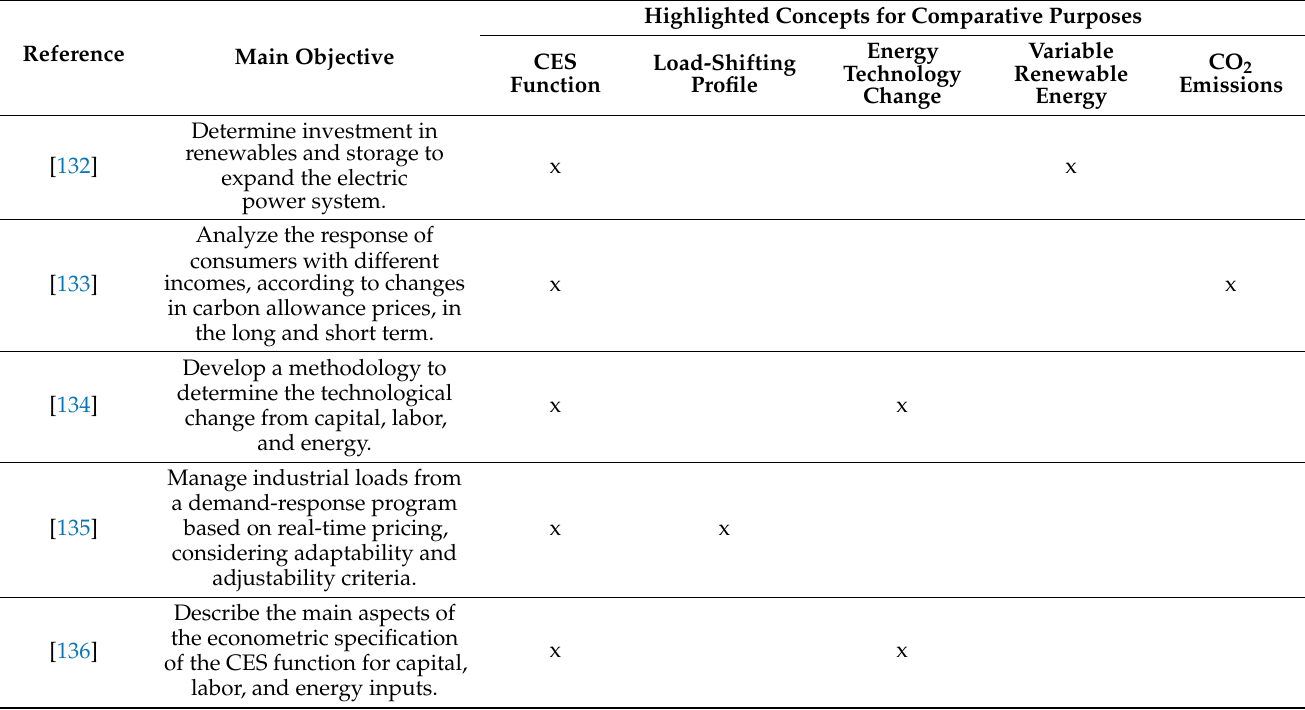
Table 4. Summary of energy management proposals based on CES